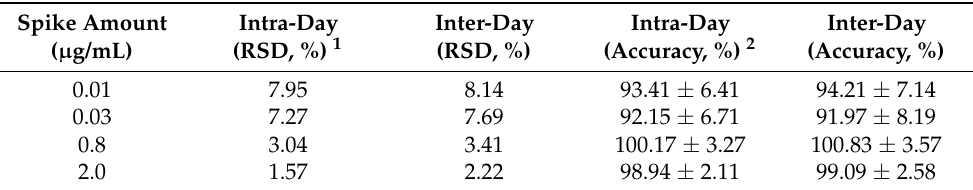
Table 2. Intra- and inter-day precision and accuracy for quantification for SFN in rat plasma by the HPLC method.